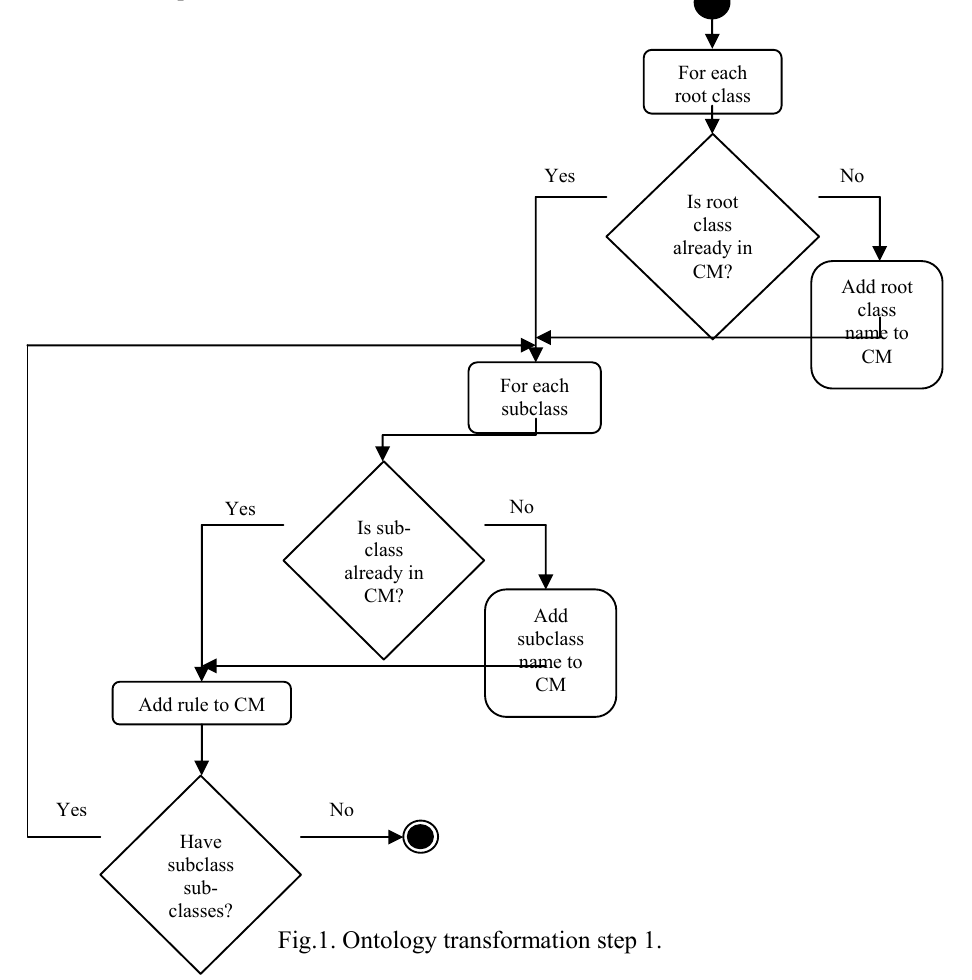
Fig.1. Ontology transformation step